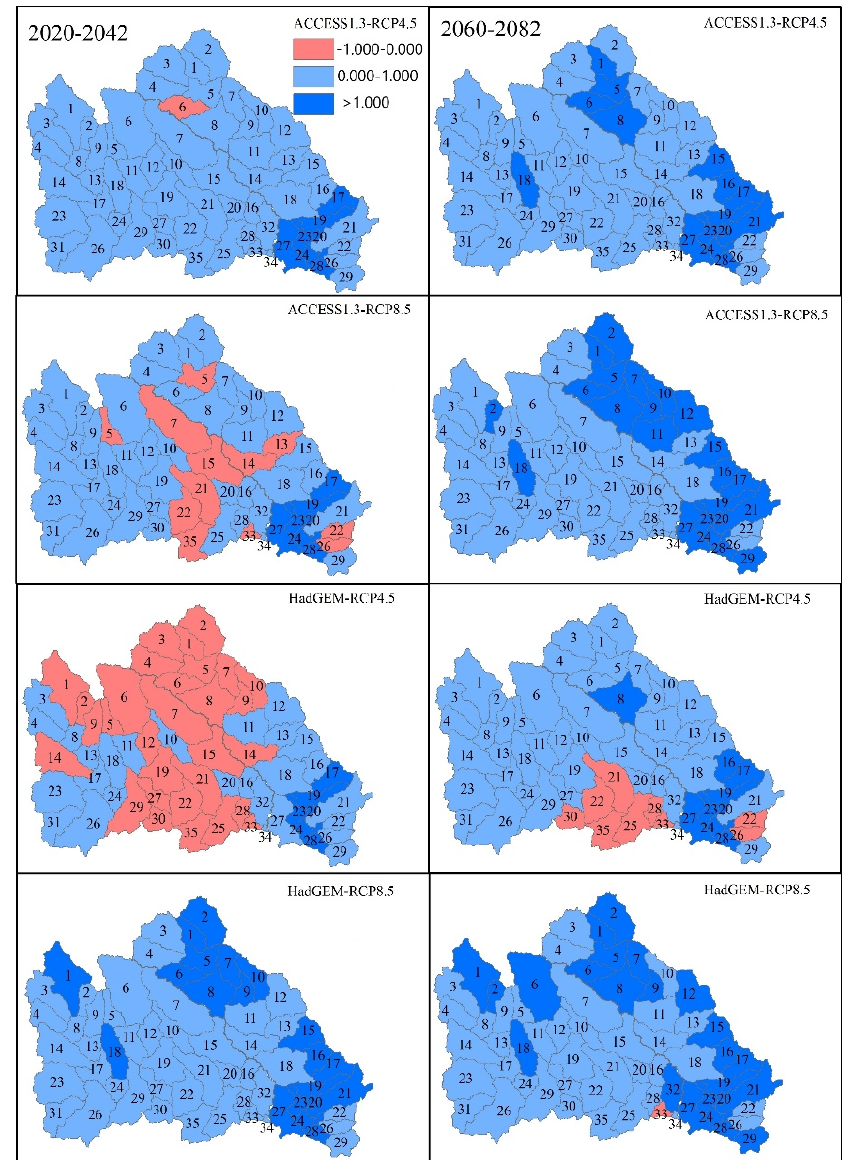
Figure 11. Spatial distribution of total nitrogen under different climate change projections.